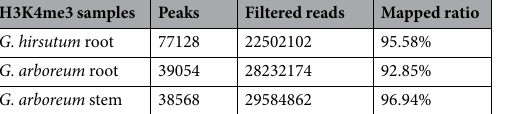
Table 1. The statistics of reads mapped and peak prediction in H3K4me3 ChIP-seq data among two tissues and species in